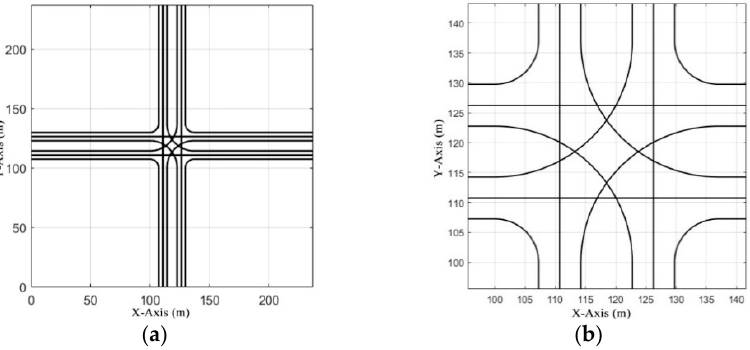
Figure 13. The geometry of the unsignalized intersection. ( a ) Overview; ( b ) detailed drawing.